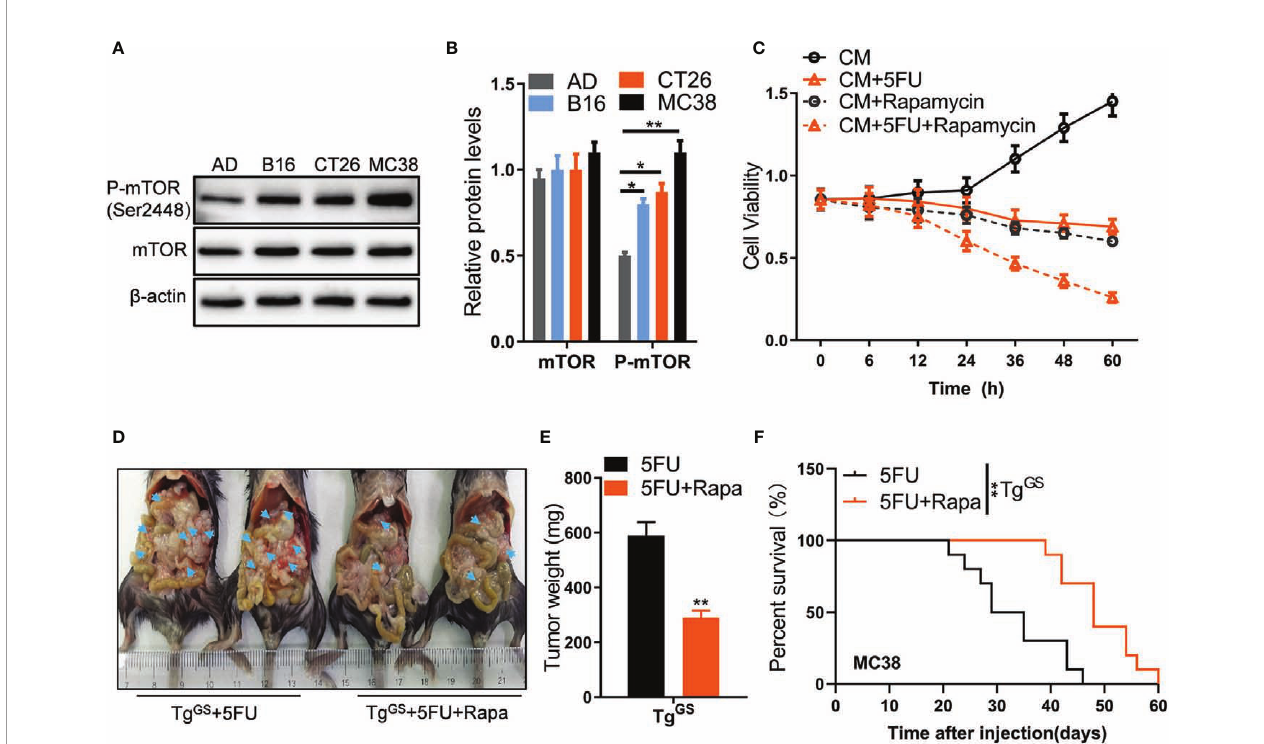
FIGURE 5 | Tumor cells outcompete adipose cells for glutamine via mTORC1. (A) The protein levels of mTOR and p-mTOR (ser2448) in AD, B16, CT26, and MC38 cells were measured with Western blot. (B) The relative protein levels of mTOR and p-mTOR in (B) were calculated (n = 3, * P < 0.05, ** P < 0.01). (C) Cell viability of CT26 cells treated with CM CM+5FU (10 m mol/L), CM+Rapamycin, or CM+5FU+Rapamycin by CCK8 assays (n = 5). (D) Mice were intraperitoneally inoculated with CT26 cells which were treated with 5FU, Rapamycin, or 5FU+Rapamycin, respectively. Then, the representative images of the mice-bearing tumors were shown. Arrow heads, tumors. (E) The tumors in (D) were isolated and weighed (n = 5, ** P < 0.01). (F) Kaplan-Meier curves for the survival of 5FU-treated or 5FU+ Rapamycin -treated TG GS mice after MC38 tumor cell inoculation plotted against time (days after injection) (** P <